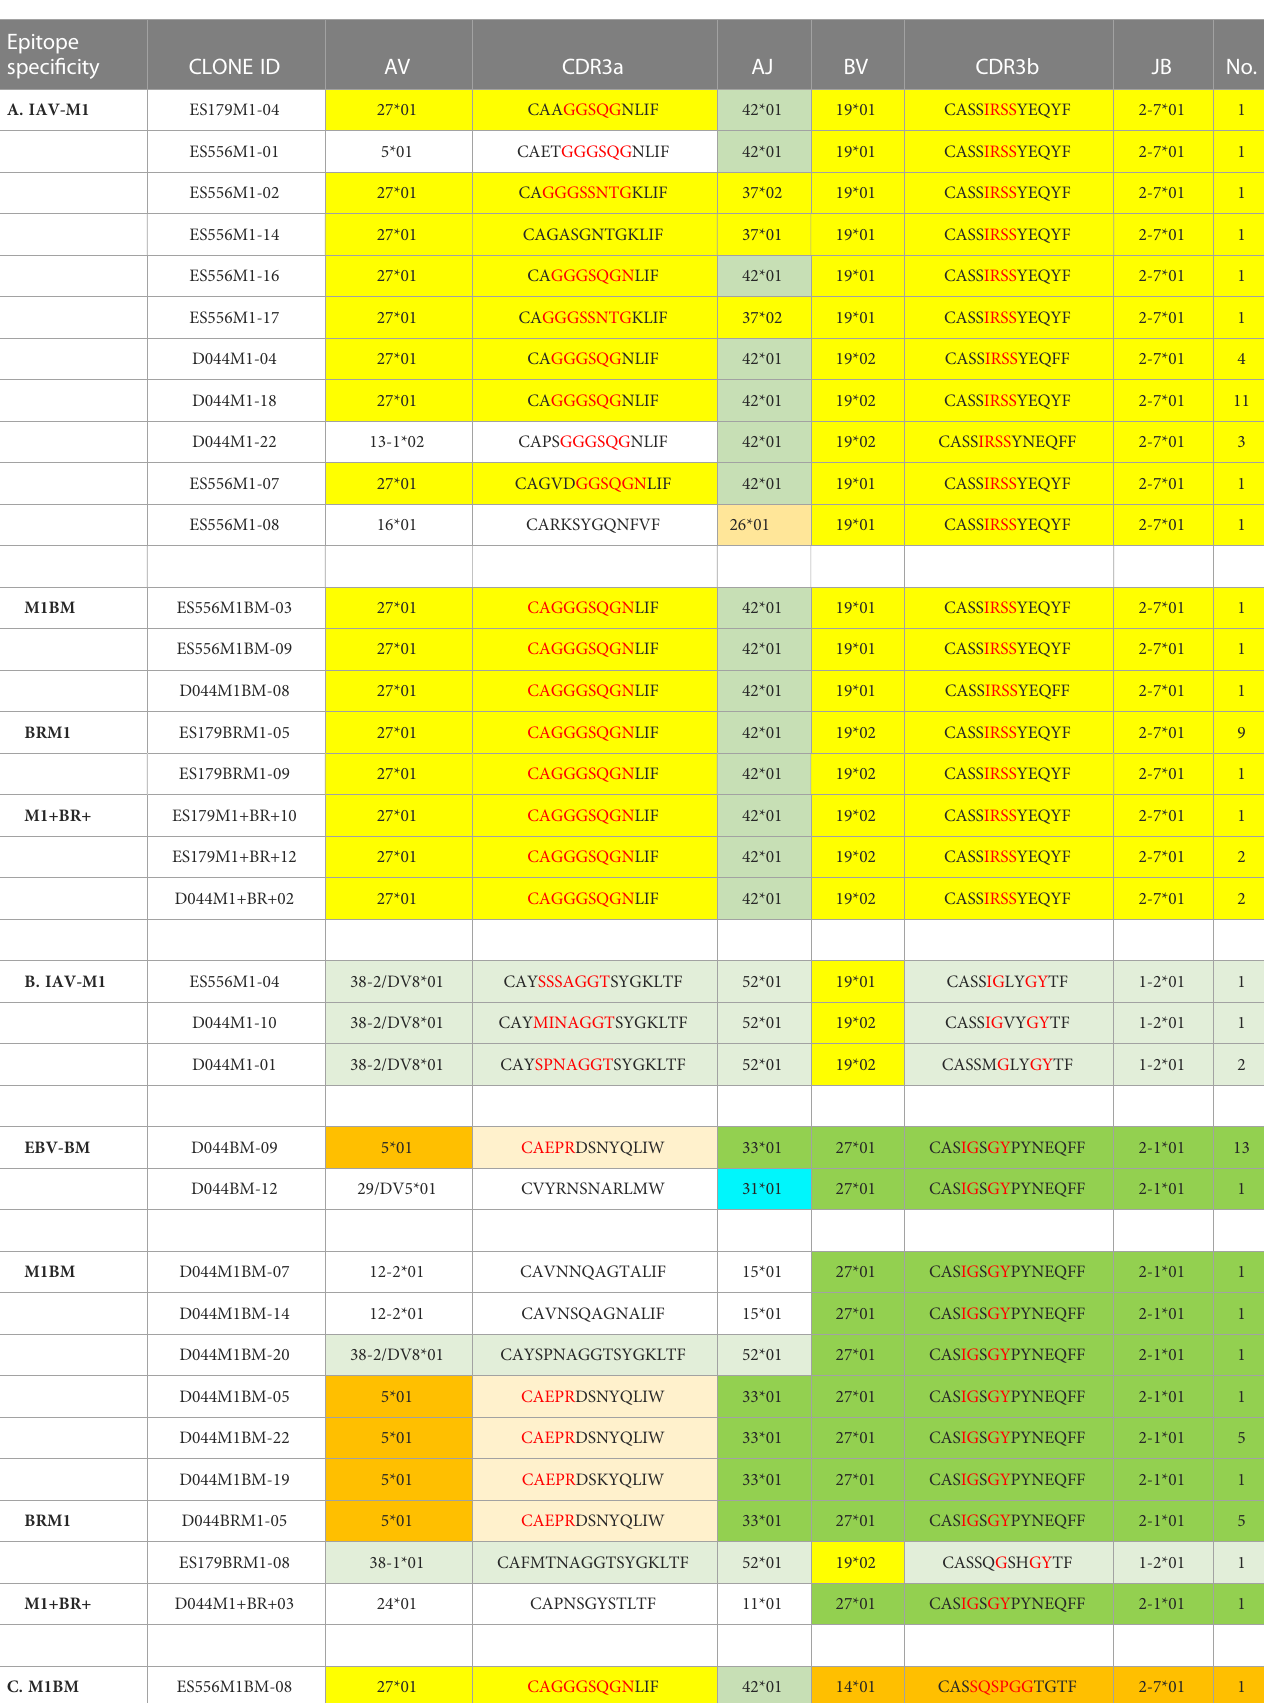
Red text highlights motifs. Color blocking highlights